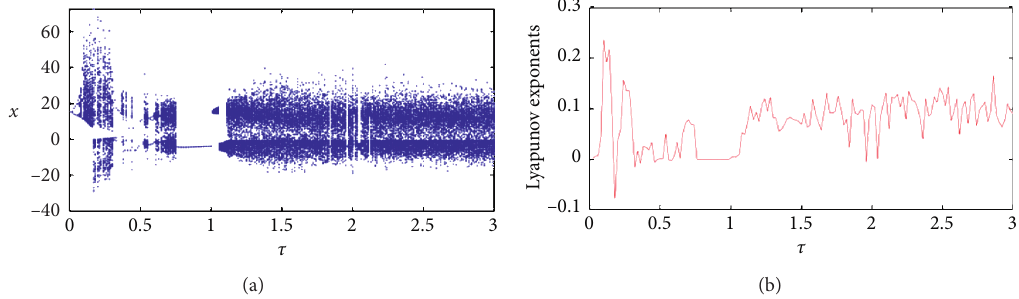
Figure 1: Bifurcation diagram (a) and Lyapunov exponents variation (b) of the total system risk x with the variation in the lag parameter τ